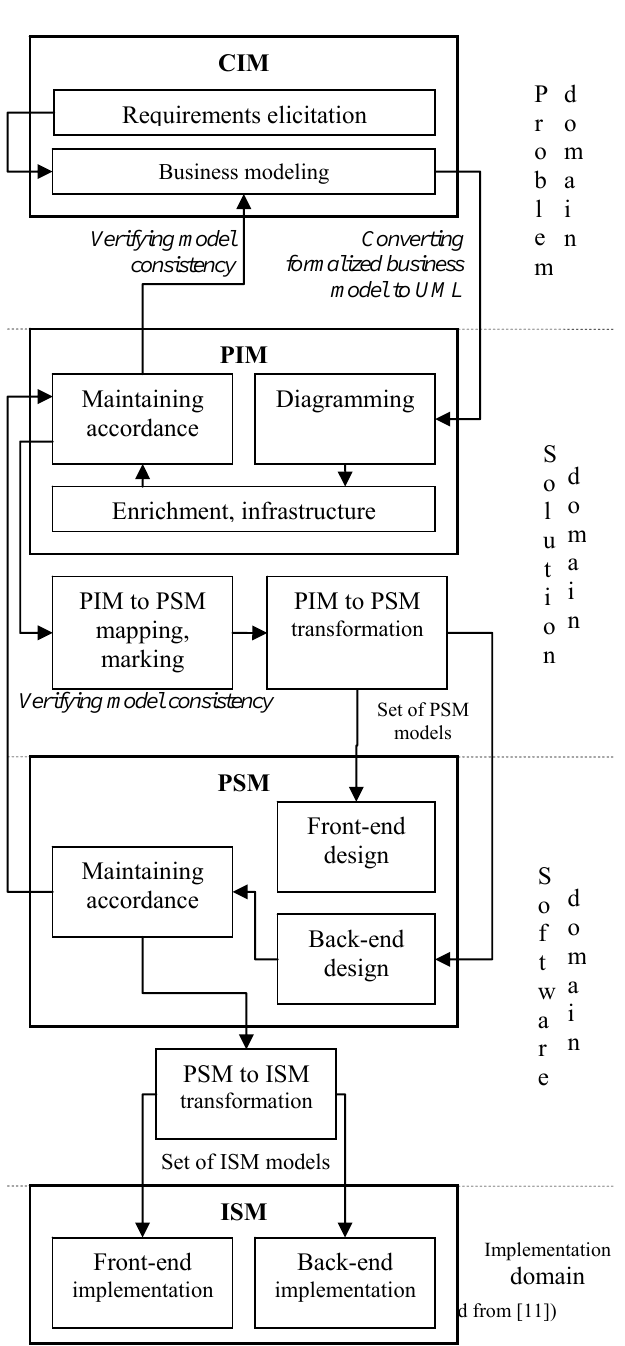
Fig. 1. The component model of MDA (adapted from